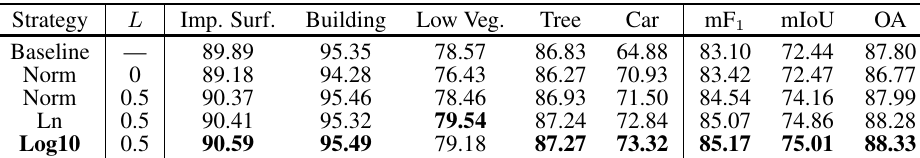
Table 2. The influence of different weight transformation strategies based on the